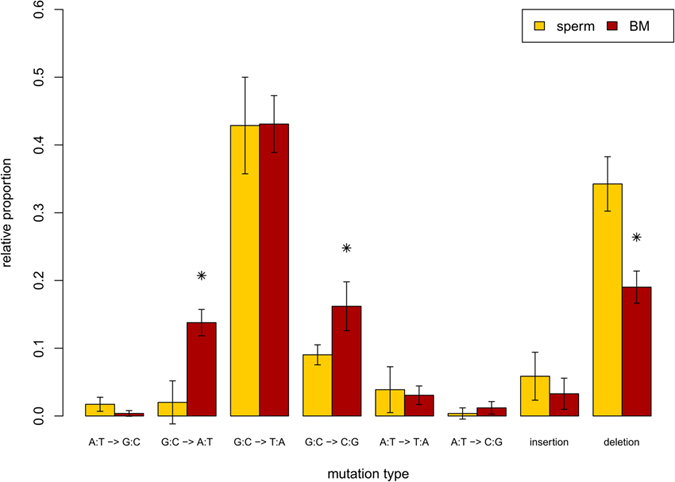
Comparison of the proportion of benzo[a]pyrene (BaP)-induced mutation types in the lacZ gene isolated from sperm and bone marrow.*Indicates significant differences (p < 0.05) between tissues. Bone marrow data are from a previously published study16.